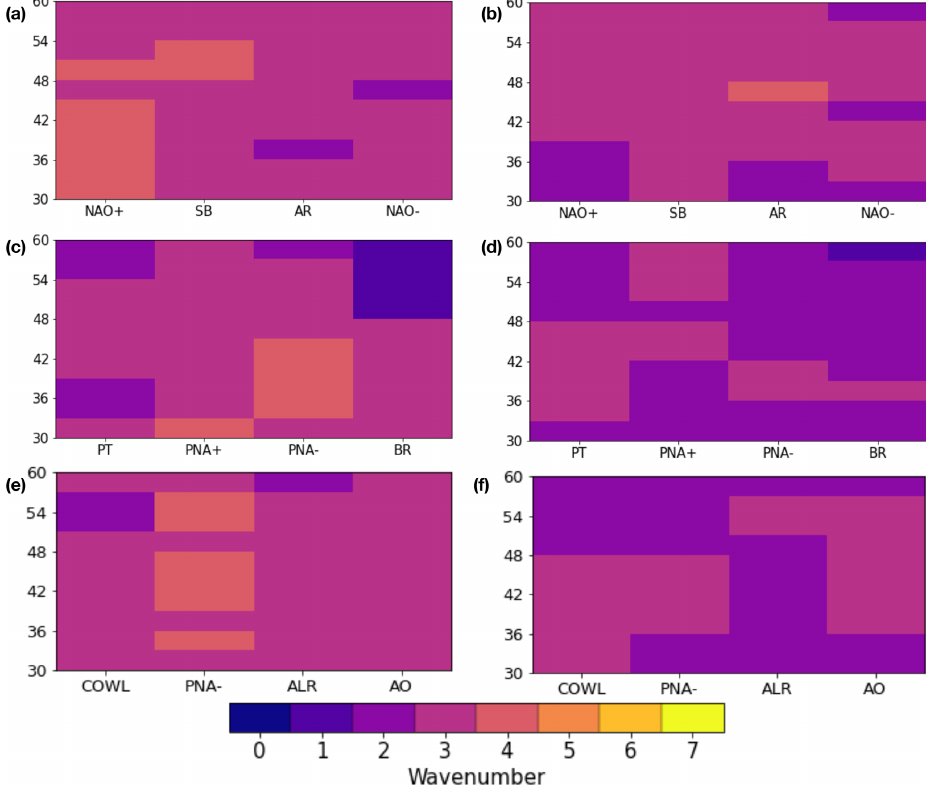
Figure 9. Time-averaged zonal wavenumber associated with meridional-energy-transport extremes (see text) for DJF clusters obtained in different regions, as a function of the latitude at which the extreme is found. (a) EAT region, poleward extremes; (b) EAT region, equatorward extremes; (c) PAC region, poleward extremes; (d) PAC region, equatorward extremes; (e) NH region, poleward extremes; (f) NH region, equatorward